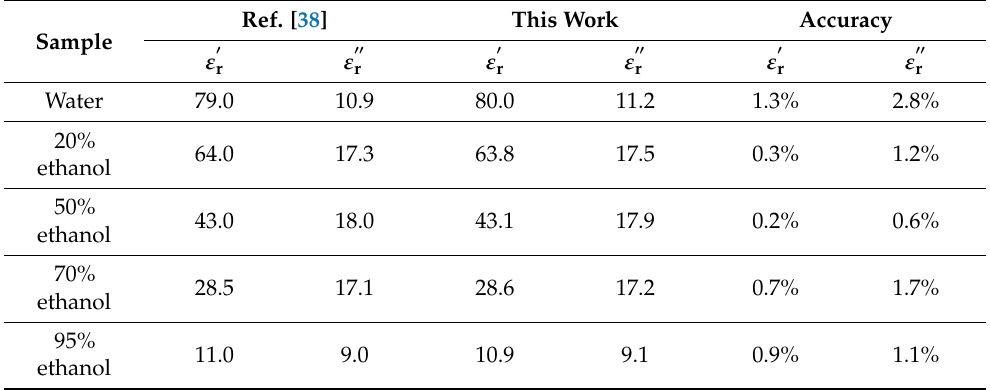
Table 3. Comparison between measured results of this work and data in the literature [38].